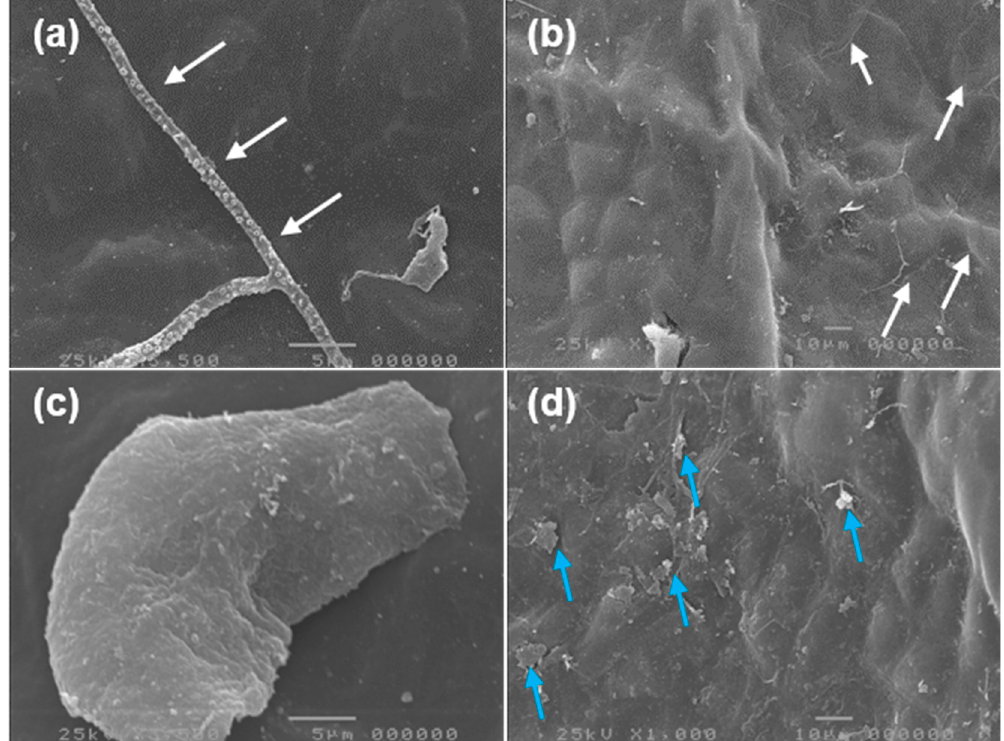
Figure 2. SEM micrographs of the abaxial and adaxial side of the Andiroba leaf surface reveal ( a , b ) Trichomes and ( c , d ) epicuticular waxes for abaxial and adaxial sides, respectively.